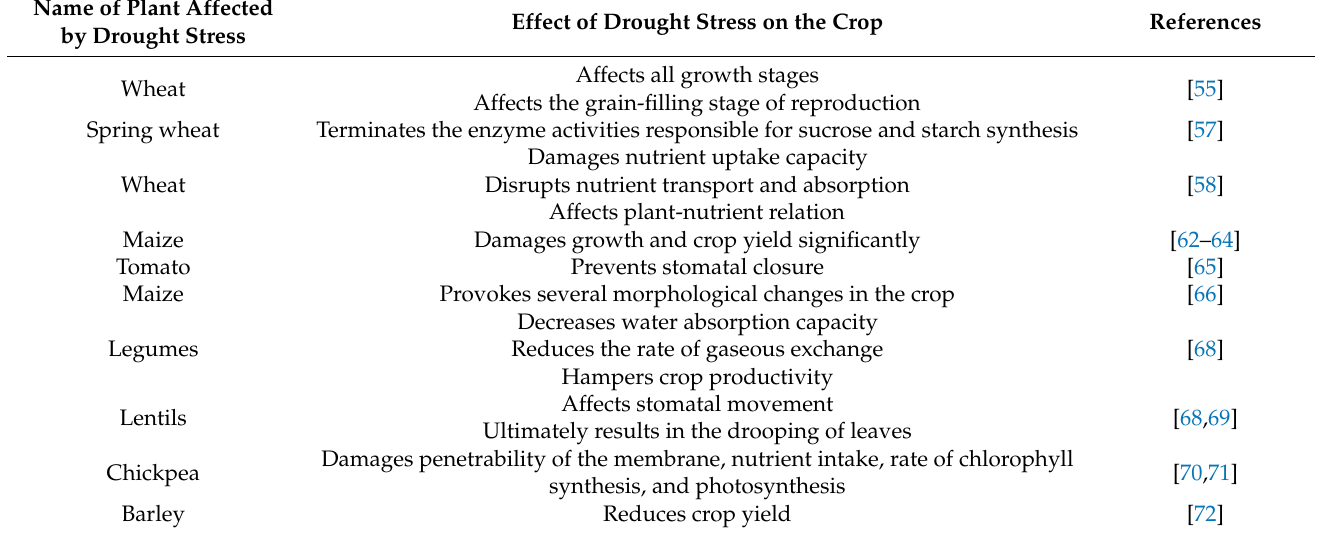
Table 2. Impact of drought stress on a variety of